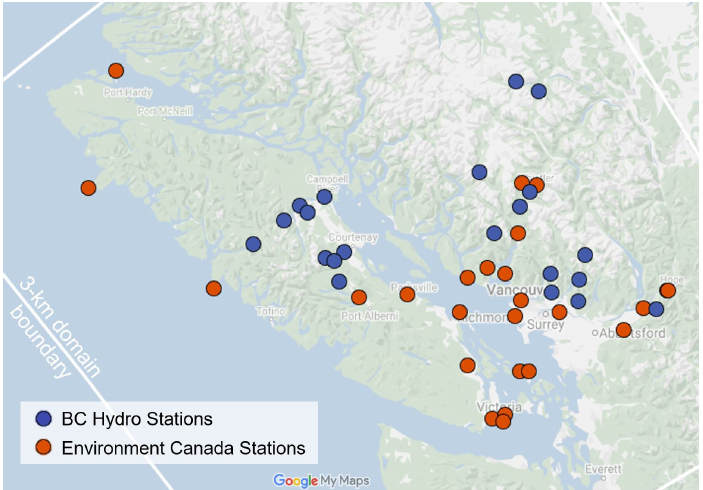
Figure 1. Domain of interest in southwest British Columbia with locations of 46 stations that provide hourly precipitation observations from two